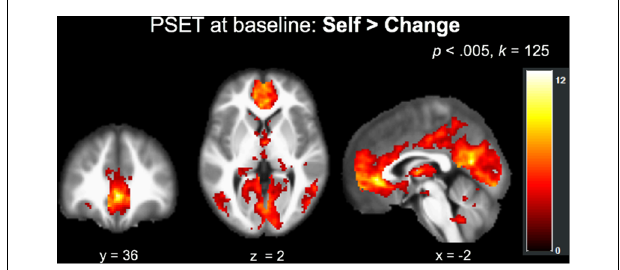
FIGURE 4 | Recruitment of regions implicated in self-processing during the PSET (Self > Change) at baseline across the entire sample ( N = 37).